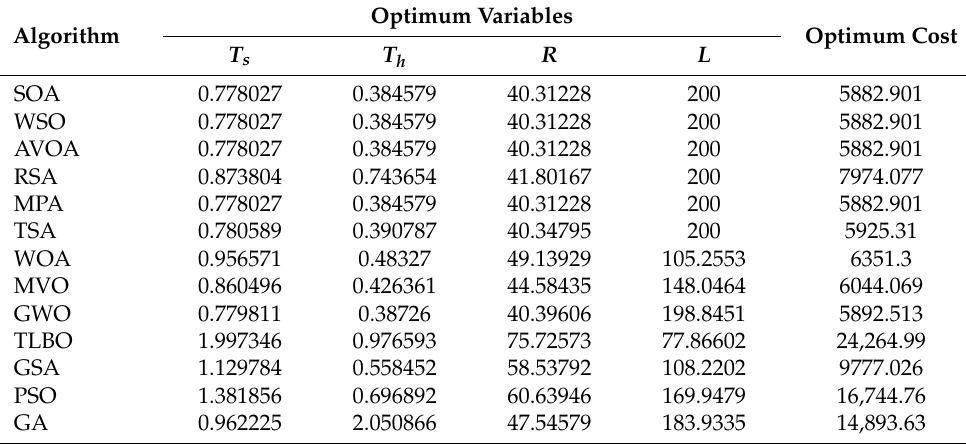
Table 9. Performance of optimization algorithms on the pressure vessel design problem.